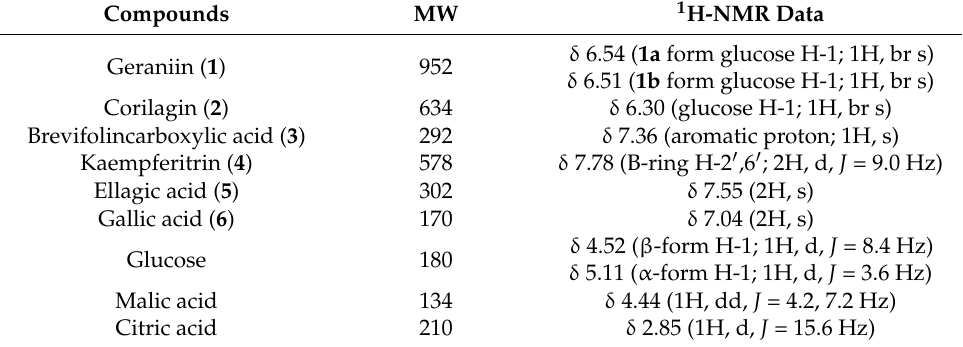
Table 1. Specific 1 H-NMR data of main ellagitannins and the other compound of G. thunbergii